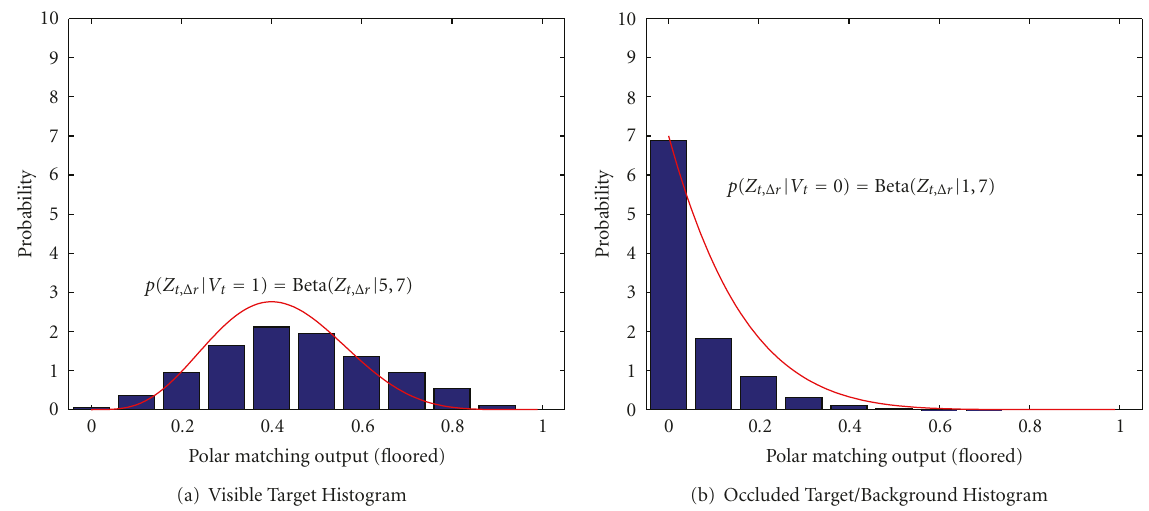
Figure 5: These figures show the Visible and Occluded Target/Background histograms for 100 video frames and their respective Beta distributions chosen to model